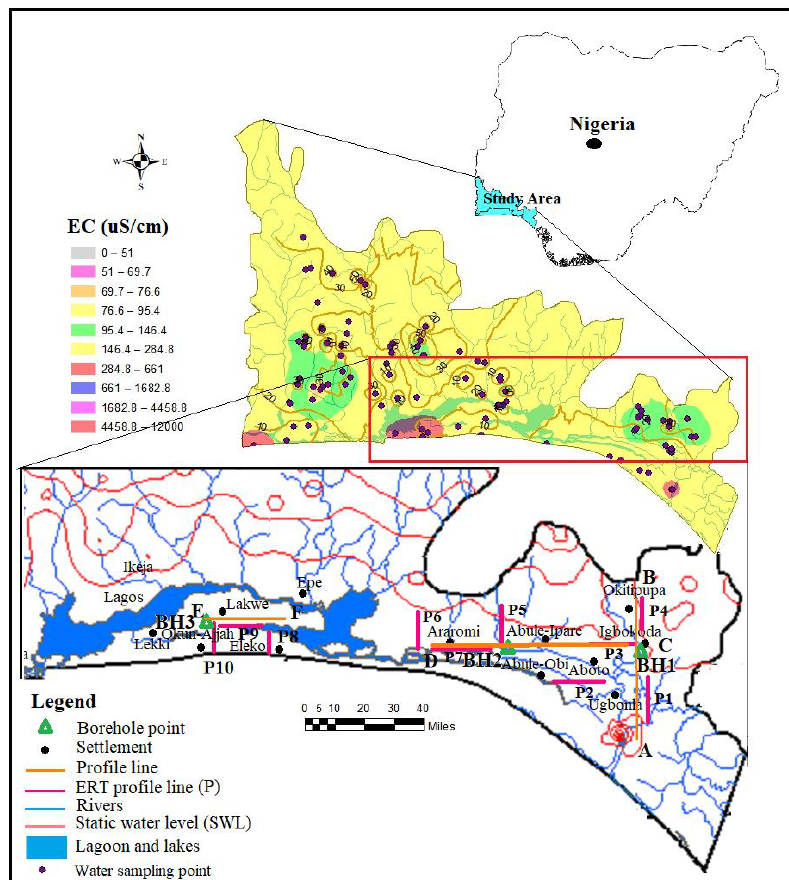
Figure 3. Map of the Eastern Dahomey Basin showing well sampling points, borehole points and geoelectrical profile and spatial distribution map of electrical conductivity (EC).